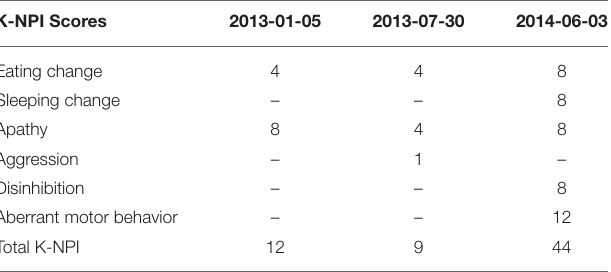
TABLE 1 | Neuropsychiatric scores of the patient were marked as eating and sleeping changes, aberrant motor behavior, aggression, apathy, and disinhibition were identified over the course of his diagnosis.